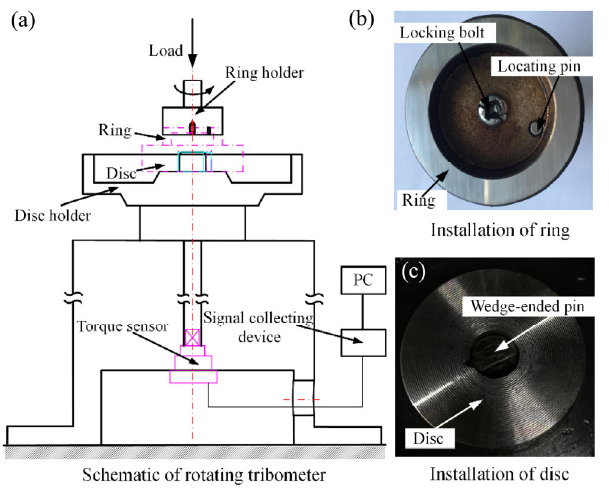
Fig. 1 Schematic of rotating tribometer and installation of specimen.